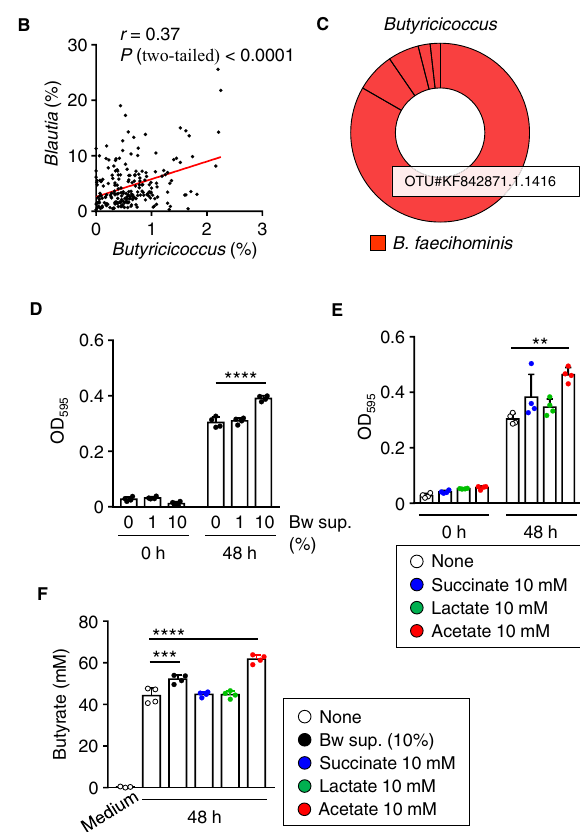
Fig. 6 | Interaction between B. wexlerae and butyrate-producing bacteria. A Heatmap showing correlated relationship among human intestinal bacteria ( n =217). Red and blue fonts indicate bacterial genera from Fig. 1 that were posi- tively or inversely, respectively, related to BMI/T2DM. B Positive correlation between Blautia and Butyricicoccus inhumanfecalsamples( n =217)(Pearson,two- tailed P value). C Estimation of Butyricicoccus species according to BlastN analysis ofrepresentativeOTUsequences. D Theabsorbanceof Butyricicoccusfaecihominis